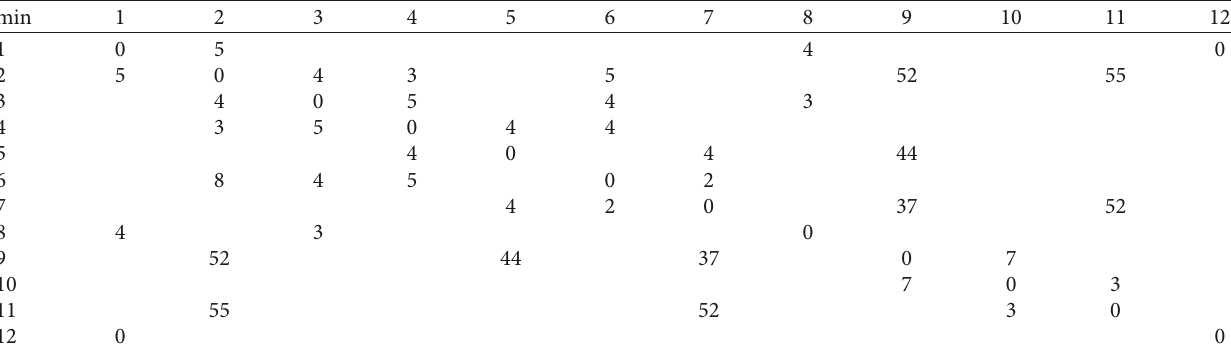
Table 15: The routing time between locations of Group